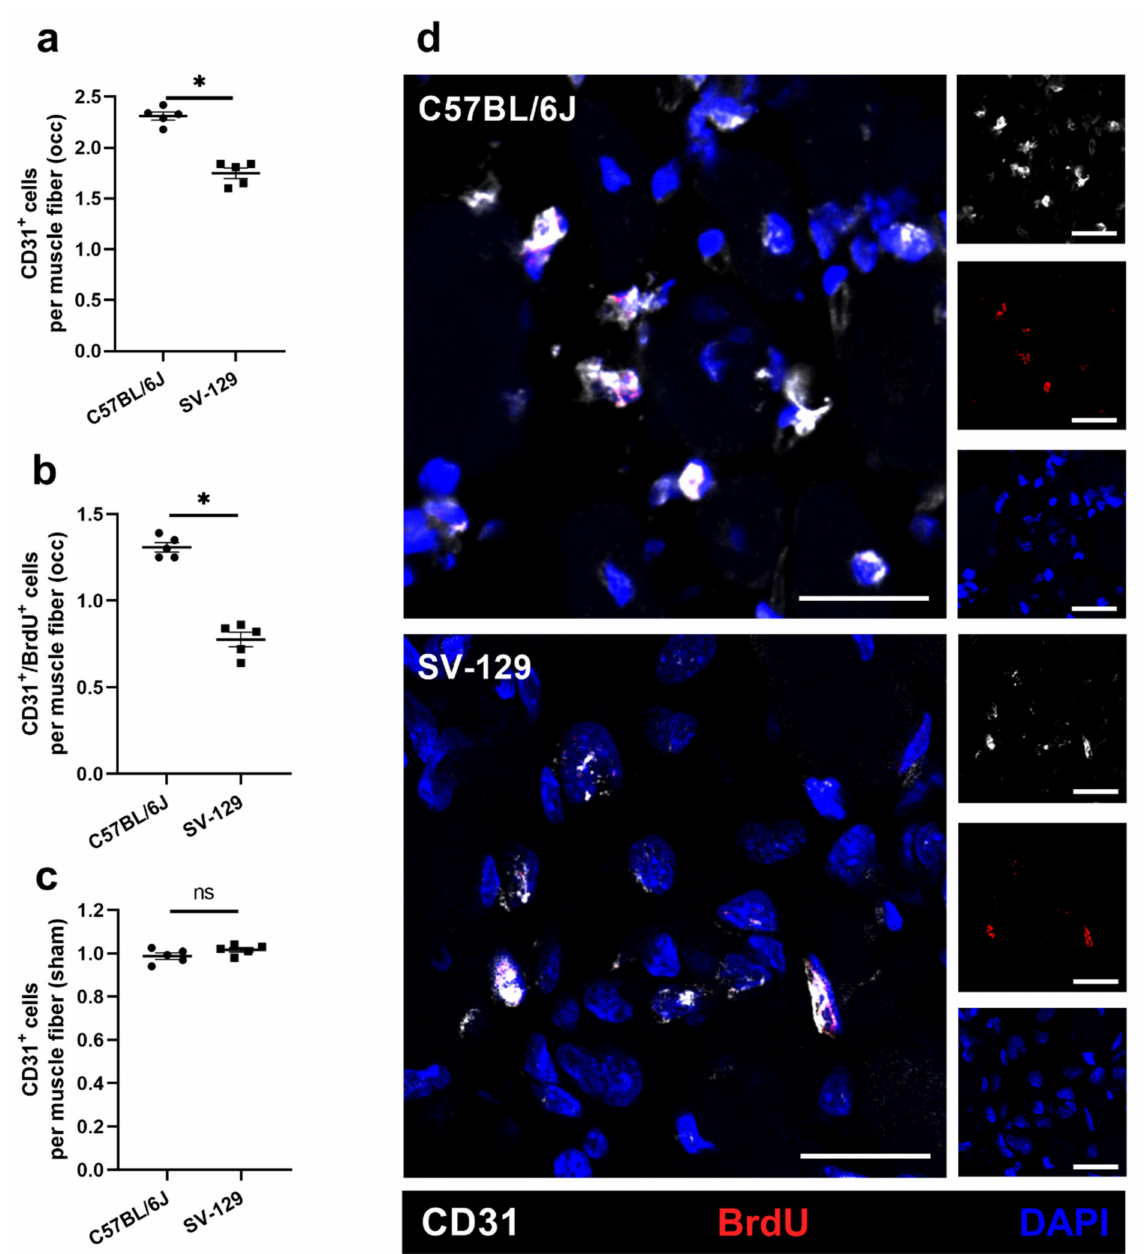
Figure 2. C57BL/6J mice show a higher capillarity under ischemic conditions than SV-129 mice. The scatter plots dis- play ( a ) endothelial cells (CD31 + /DAPI + ) per muscle fiber as well as ( b ) proliferating endothelial cells (CD31 + /BrdU + (bromodeoxyuridine)/DAPI + ) per muscle fiber of C57BL/6J and SV-129 mice in occluded (occ) ischemic gastrocnemius muscles isolated 7 days after femoral artery ligation (FAL). Scatter plot ( c ) displays the capillary-to-muscle fiber ratio of sham-operated (sham) non-ischemic gastrocnemius muscles isolated from C57BL/6J and SV-129 mice 7 days after FAL. A defined ischemic area (1.5 mm 2 ) of muscle tissue was analyzed per mouse. Data are means ± S.E.M., n = 5 per group. n.s. p ≥ 0.05, * p < 0.05 ( C57BL/6J vs. SV-129 ) by unpaired, two-sided Student’s t -test. ( d ) Representative immunofluorescence staining of ischemic gastrocnemius muscles of C57BL/6J (top) and SV-129 mice (bottom) collected 7 days after FAL. Cells were stained with an antibody labeling CD31 (white), BrdU (red), and DAPI (blue) to label nucleic DNA. Scale bars: 20 µ